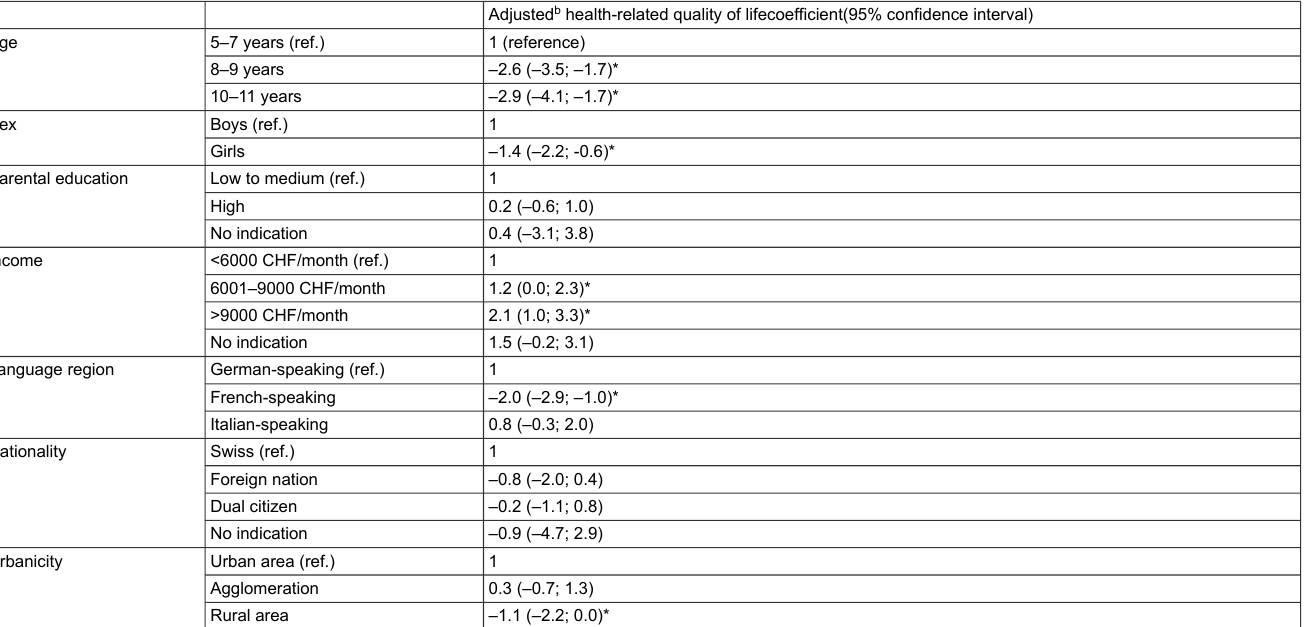
Supplementary Table 1: Association of health-related quality of life with sample characteristics (n = 1,712 a